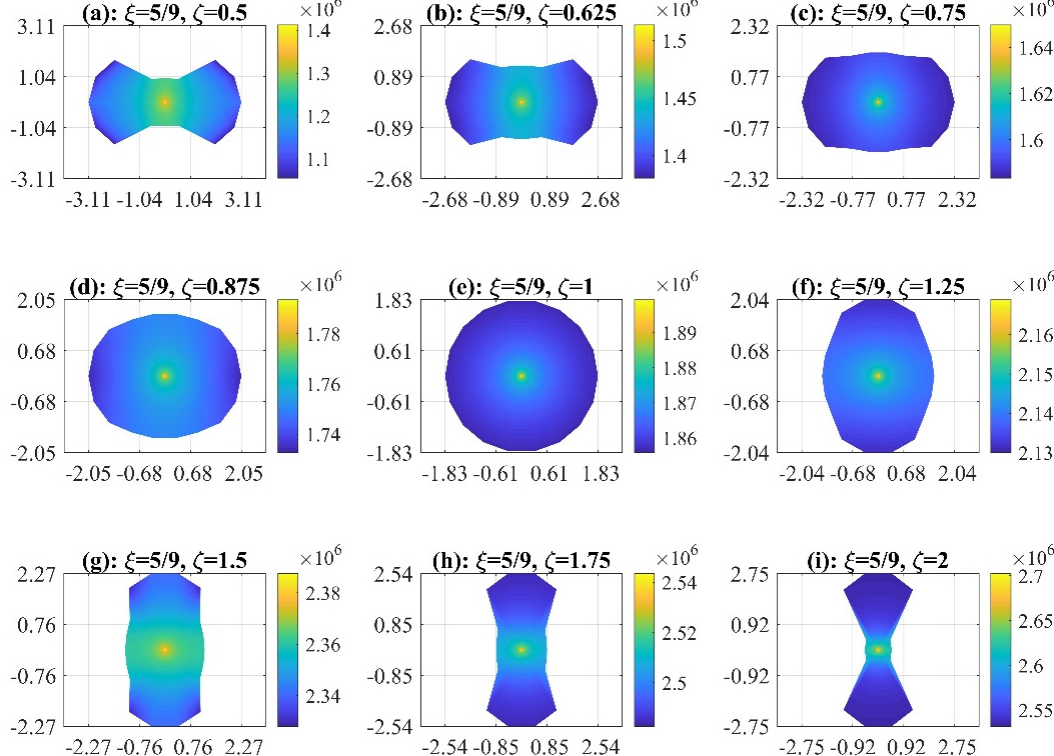
Figure 8. Distributions of fluid pressure of Group 3 numerical experiments ( ξ = 5/9) with 9 different fracture toughness contrasts at the moment = 20 s .